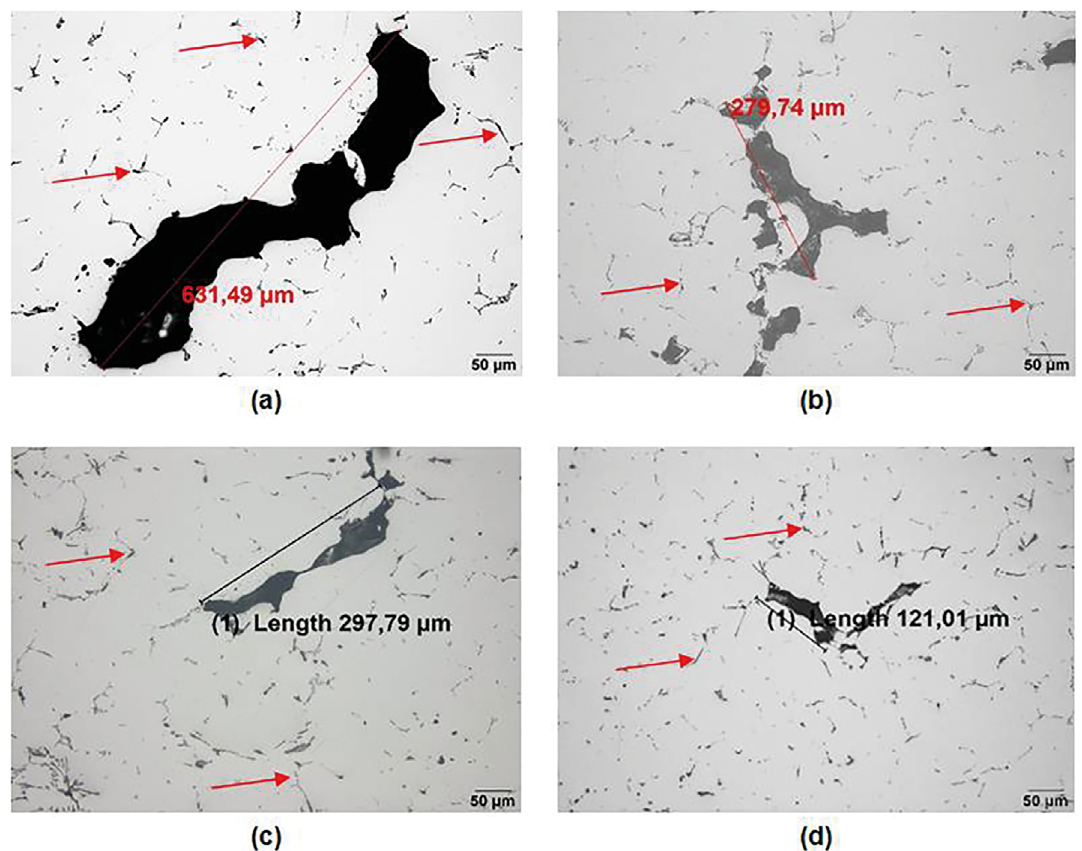
Figure 4. Microstructures of samples a) A1, b) A2, c) B1, d) B2 (β precipitates are pointed with red